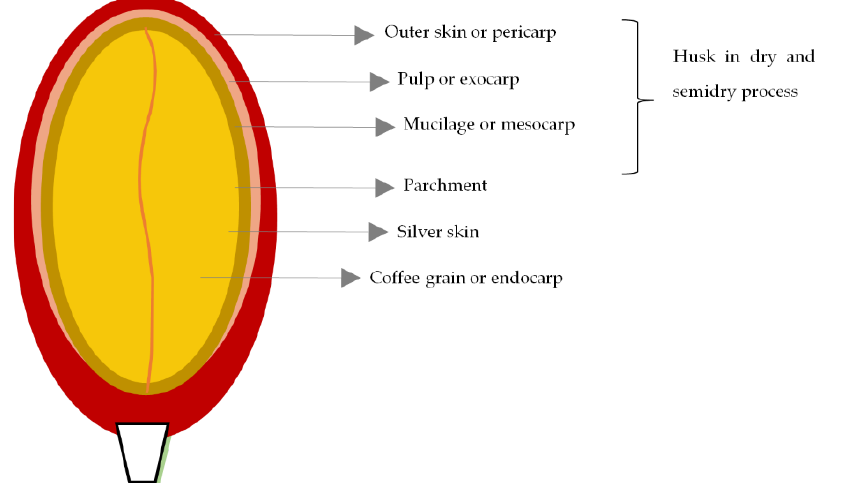
Figure 2. Coffee fruit structure.